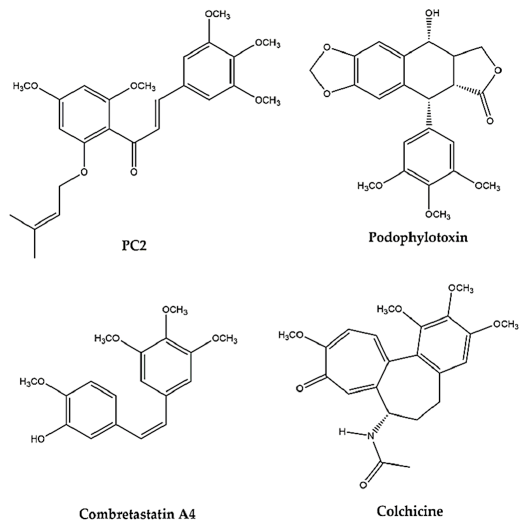
Figure 1. Chemical structures of prenylated chalcone (PC2), podophylotoxin, combretastatin A4 and colchicine.